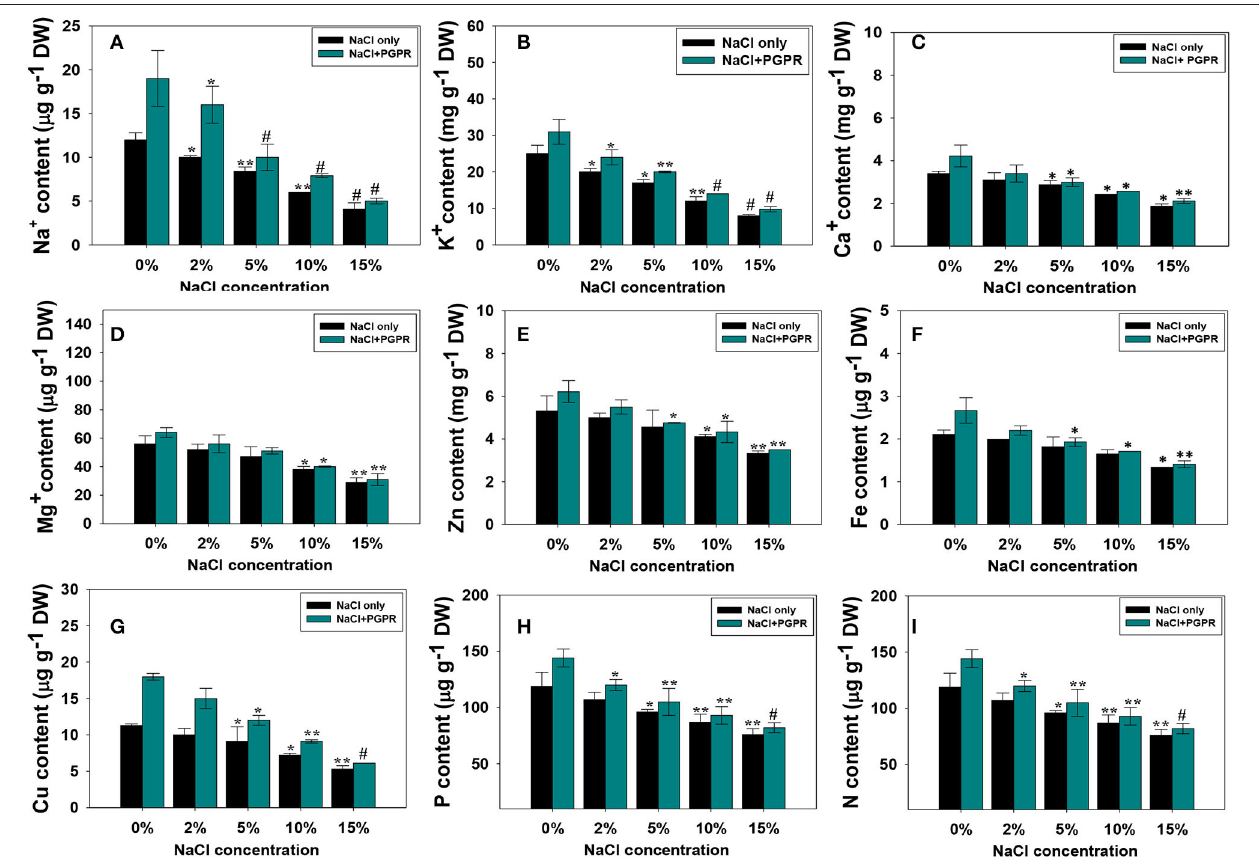
FIGURE 5 | Mineral composition; Na + (A) , K + (B) , Ca + (C) , Mg (D) , Zn (E) , Fe (F) , Cu (G) , P (H) , and N (I) accumulated in root tissues of radish plants raised in soils treated with different levels of NaCl and inoculated with halotolerant PGPR strain. In this figure, bar and line diagrams represent the mean values of three replicates ( n = 3). Corresponding error bars represent standard deviation (SD) of three replicates (SD, n = 3). The asterisks *, **, and # denote statistical significance at p < 0.05, p < 0.005, and p < 0.001, respectively, computed by Student’s T